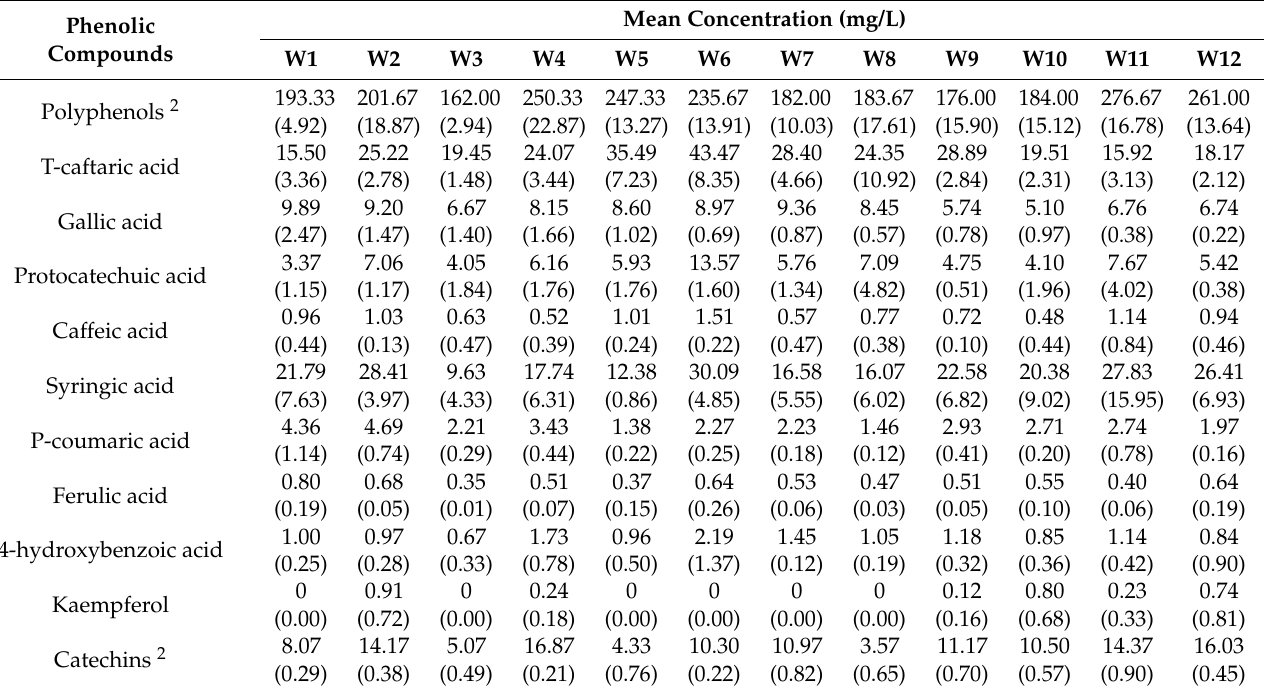
Table 2. Concentration of phenolic compounds of white wine samples (mg/L) 1